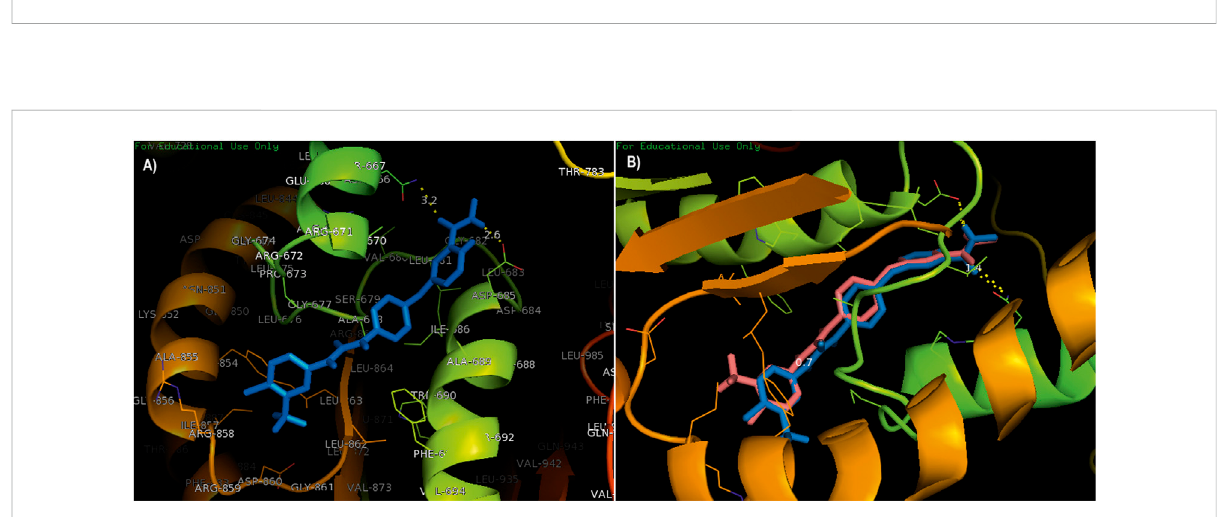
FIGURE 2 (A) Standard drug sorafenib was used to compare the binding energies and interaction pattern with those of the tested drugs. (B) Validation of docking; t he superimposition of a native co-crystallized ligand in the docked complex with the help of